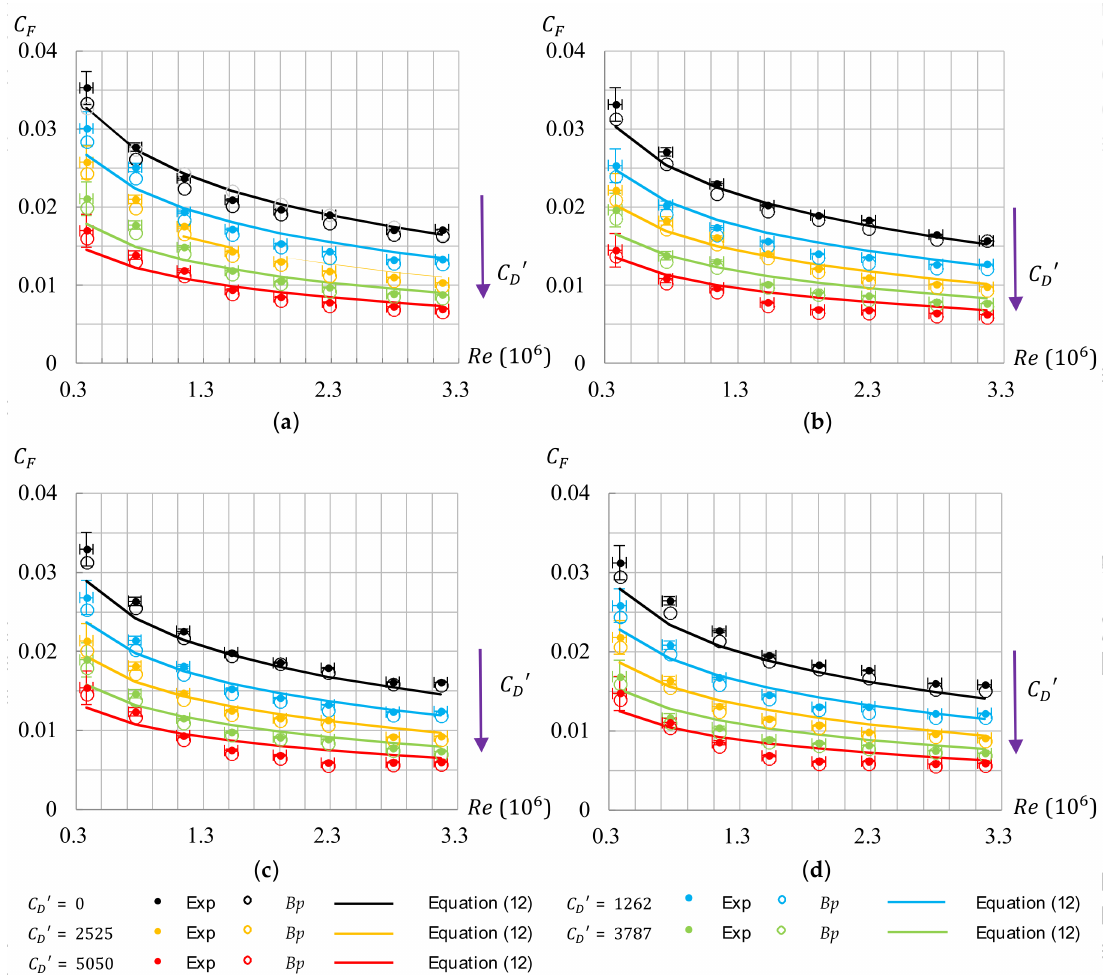
Figure 12. C F ( Re ) curves: ( a ) G = 0.018; ( b ) G = 0.036; ( c ) G = 0.054 and ( d ) G = 0.072. C D (cid:48) : through-flow coefficient; C F : axial thrust coefficient; G : non-dimensional axial gap; Re : global circumferential Reynolds